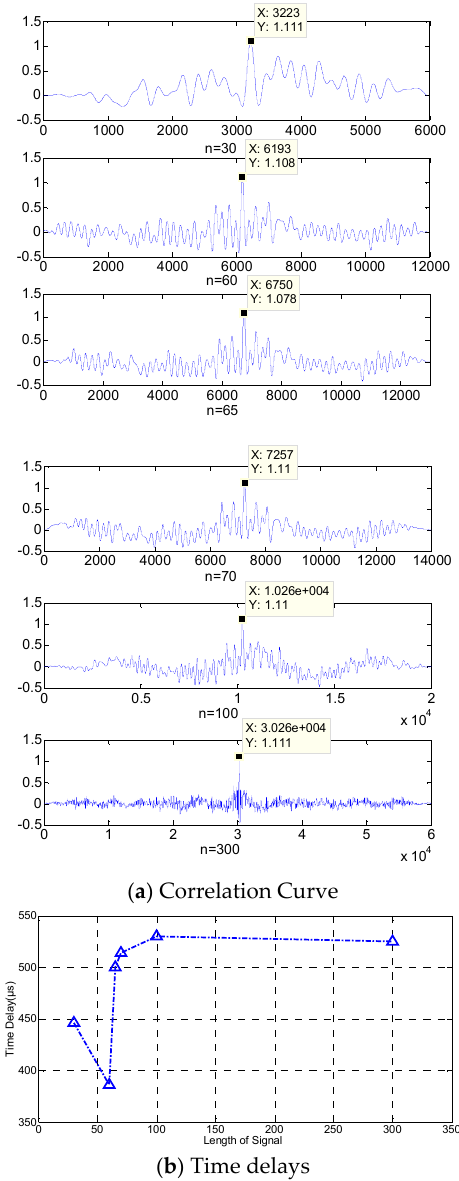
Figure 12. Correlation performance of different lengths.